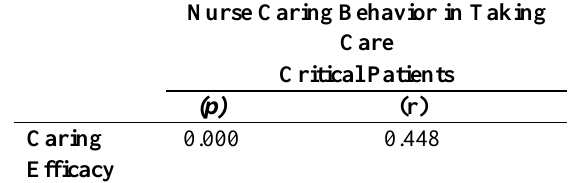
Table 3. The Correlation Test Result between Caring Efficacy and Nurse Caring Behavior in Taking Care of Critical Patients (n =